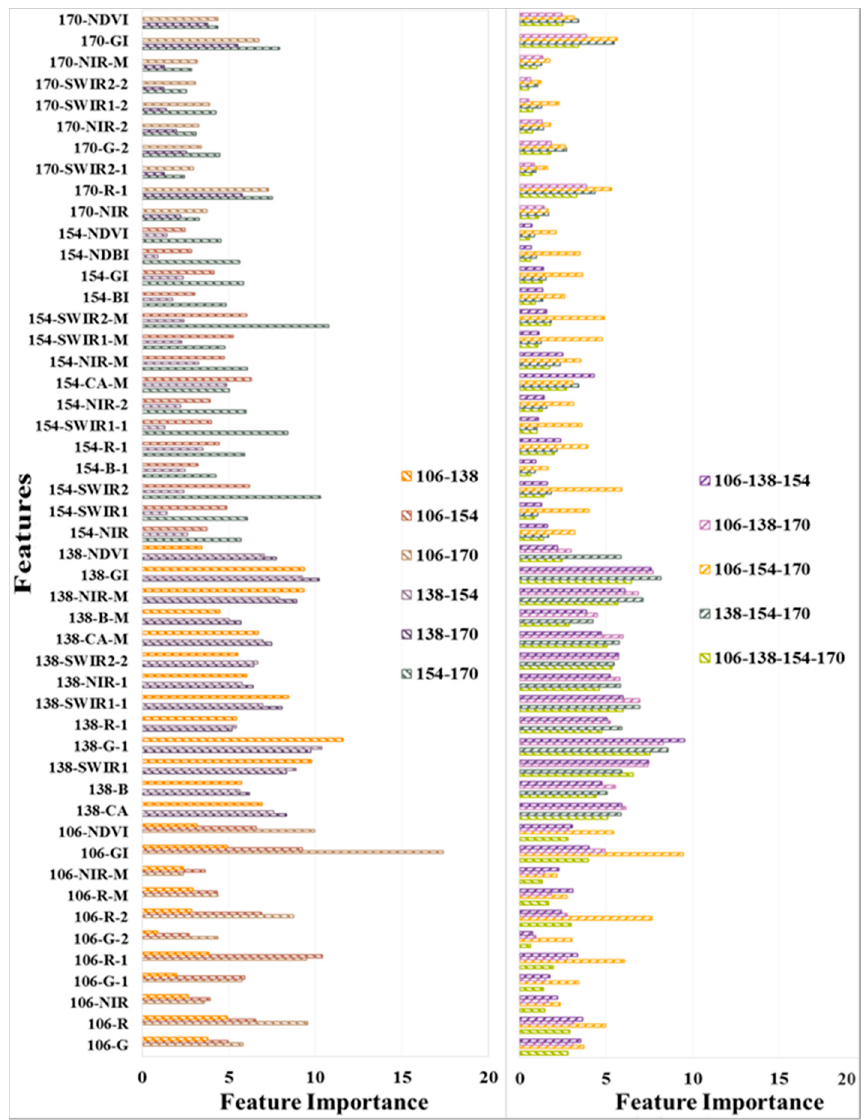
Figure 6. Importance of features in multiple-temporal combinations (106 is 16 April, 138 is 18 May, 154 is 3 June, and 170 is 19